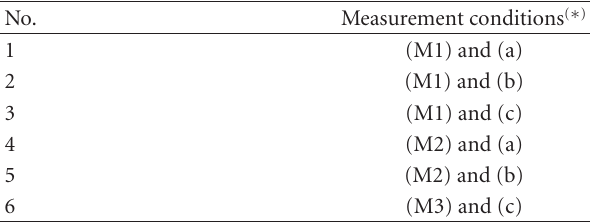
Table 2: Measurement of the human perception of force